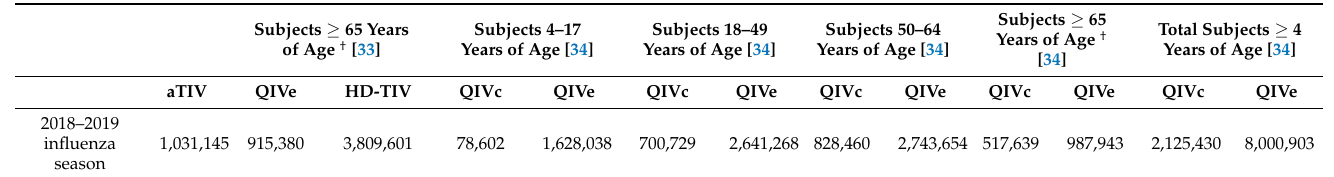
Table 2. Number of individuals with a record of receiving an influenza vaccine, by vaccine type in the 2018–2019 US influenza